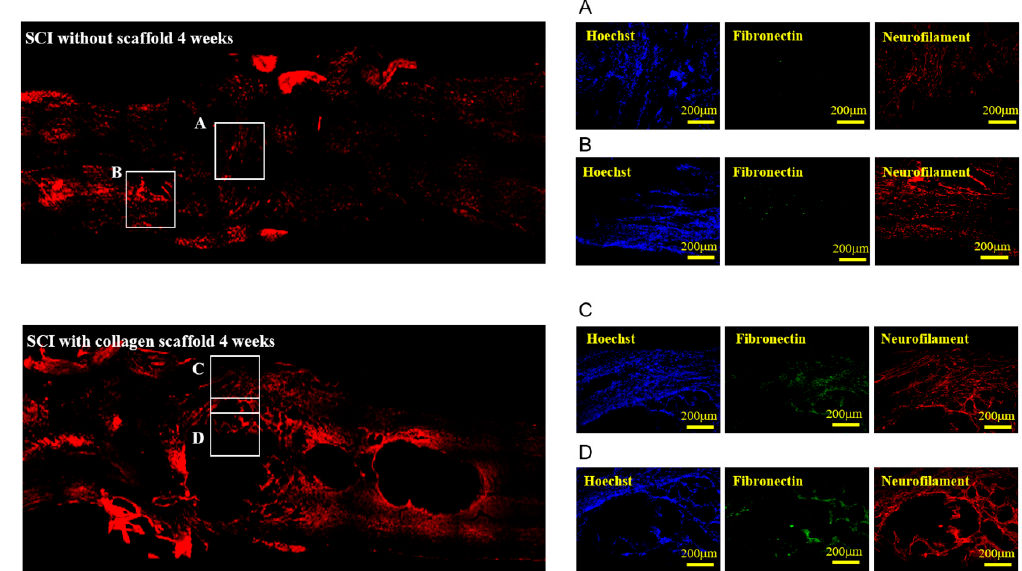
Figure 7. Immunofluorescence staining with Hoechst 33342, fibronectin, and neurofilament in the injured site of the spinal cord 1 and 4 weeks post-implantation. The enlarged images are provided as A , B , C , or D panel.